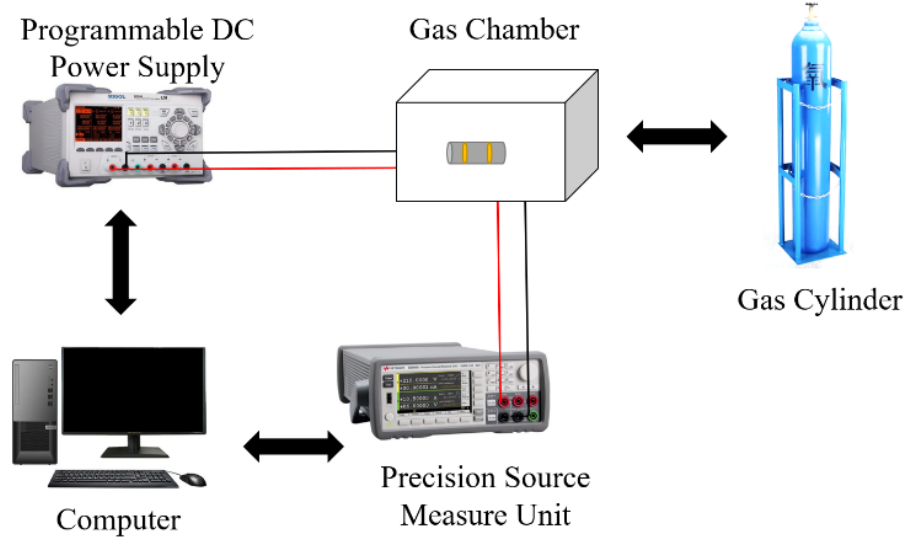
Figure 2. The diagram of the experimental apparatus.